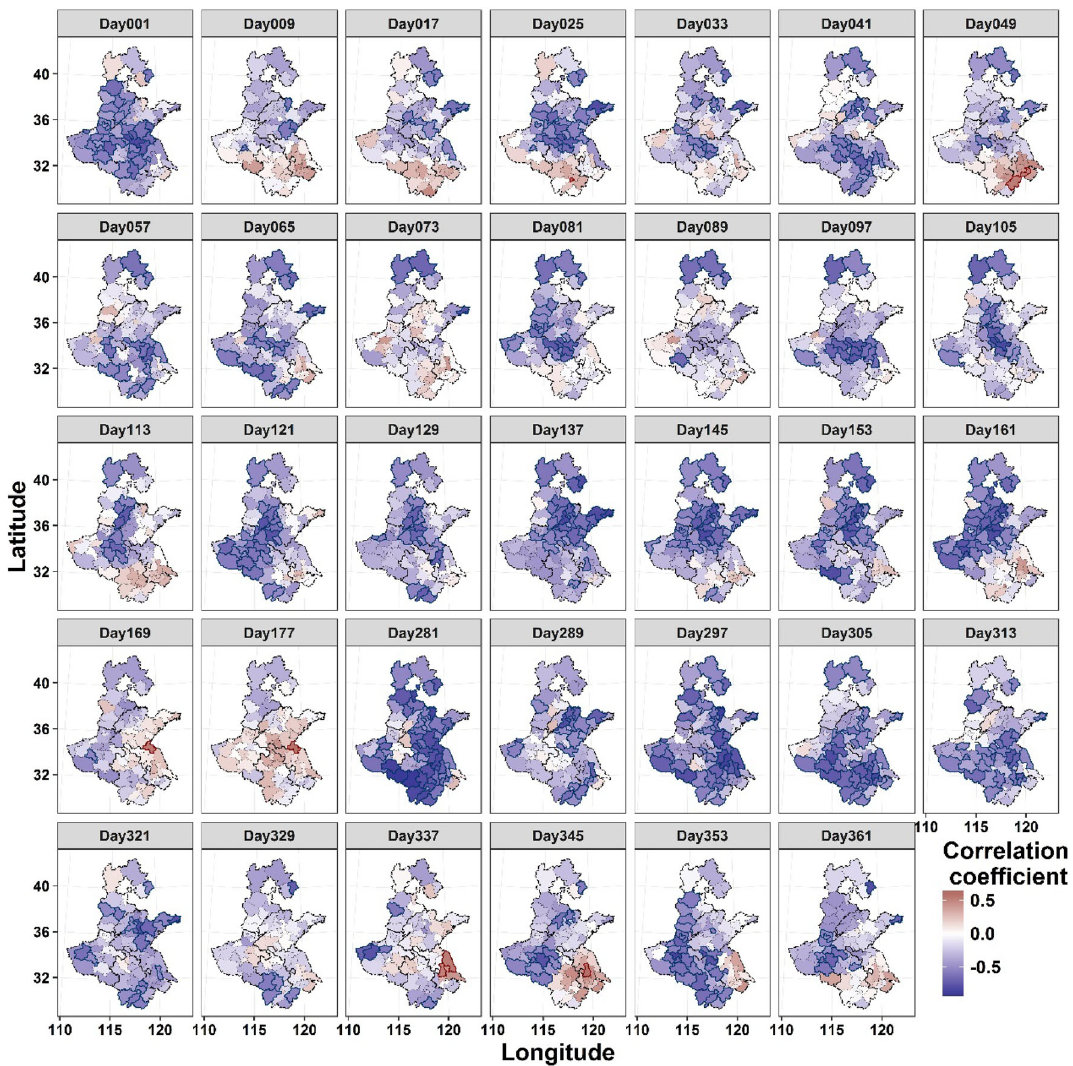
Fig. 9 Spatial pattern of correlations between severe drought-affected crop area and winter wheat yield in Anhui, Hebei, Henan, Jiangsu, and Shandong Provinces, China,